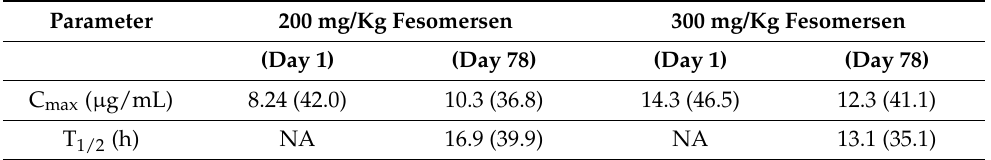
Table 9. PK parameters of fesomersen after repeated doses of 200 mg and 300 mg twice weekly for 15 days then weekly for 78 days. Data are from Walsh, M. et al. [38]. Data are presented as geometric mean (geometric % CV). NA: not available. C max : Maximum plasma concentration; T 1/2 : half-life time.